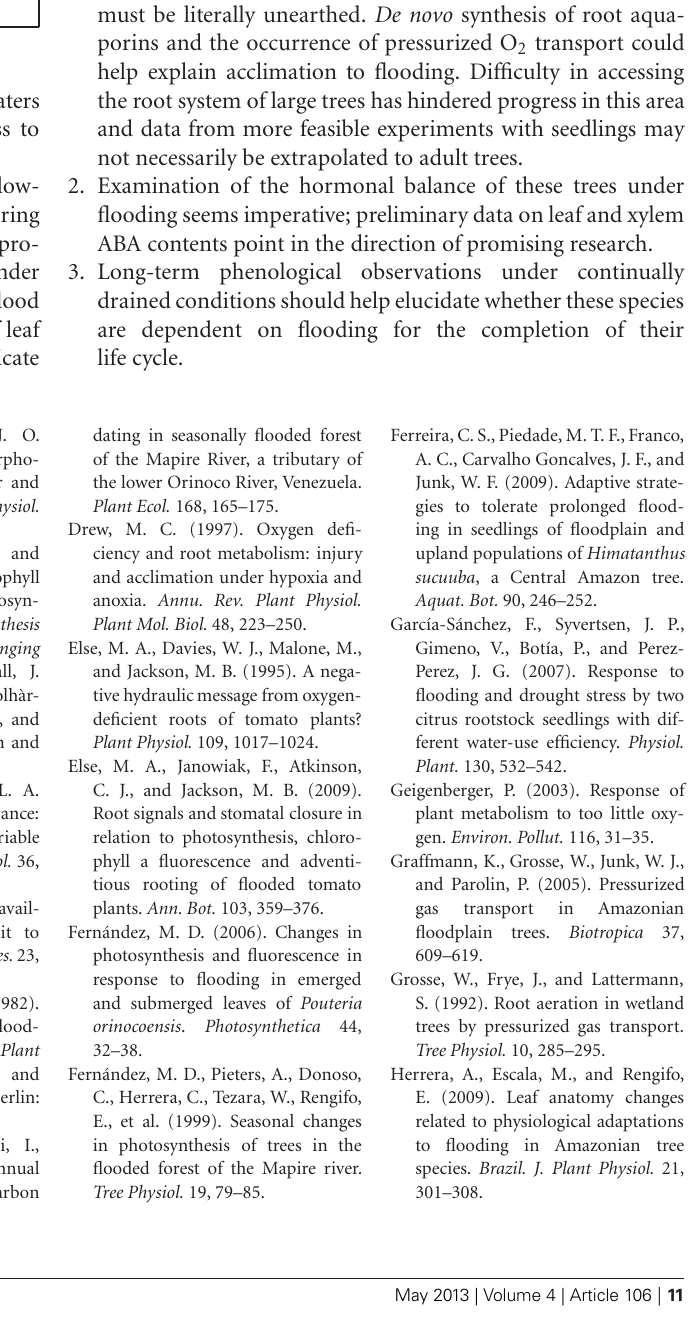
FIGURE 10 | Frequency distribution of flower (yellow) and fruit (brown) production in trees of the Mapire igapó. The blue bar on the ordinate indicates the length of the flood period. Modified from Rosales